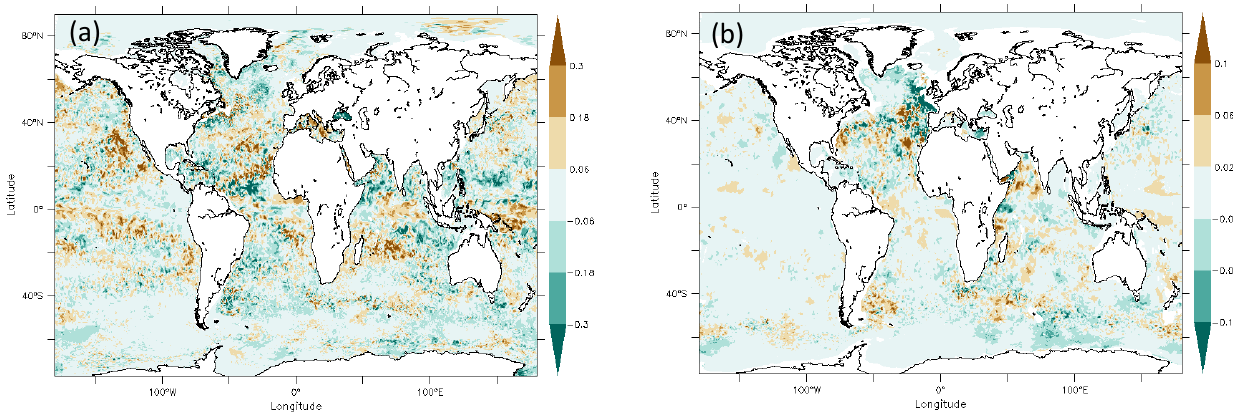
Figure 9. 19 December 2012, analyzed salinity fields – differences between Run-Ref and Run-NoArgo at 100m (a) and 1000m (b)